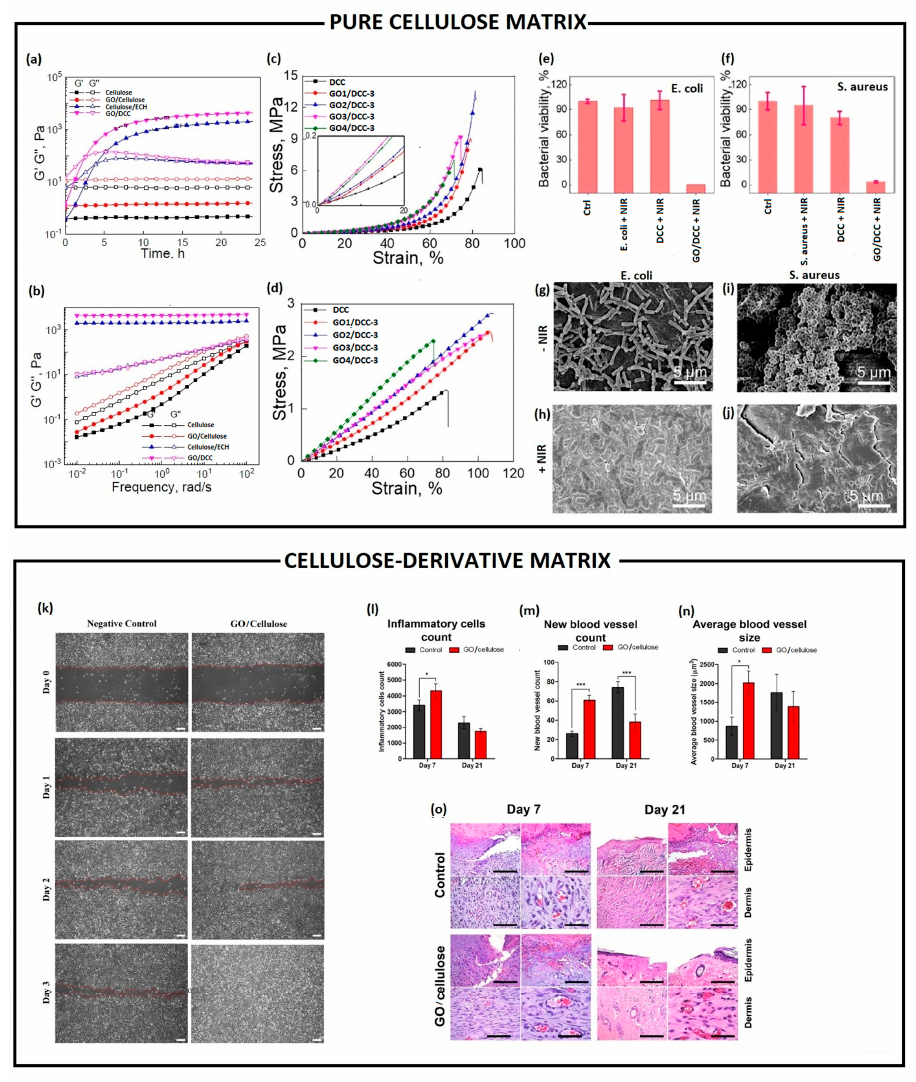
Figure 6. Pure cellulose matrix ( top ): rheological characterizations: ( a ) time- and ( b ) frequency-de- pendence of the storage modulus (G ′ ) and loss modulus (G ″ ) of a cellulose, cellulose/GO (2 wt%), cellulose/ECH (ECH:DCC molar ratio = 0.86), and cellulose/GO (2 wt%)/ECH (ECH:AGU molar ratio = 0.86). Mechanical characterizations: ( c ) compression strain–stress curves and ( d ) tensile strain– stress curves of cellulose/GO/ECH composite hydrogels with different GO contents. The insets show magnified plots of the responses in the low-strain range. Antimicrobial studies: relative percentage survival of ( e ) E. coli and ( f ) S. aureus after incubation with composite hydrogels with and without GO under NIR laser irradiation (power density of 2 W/cm 2 under 808 nm). SEM micrographs of E. coli ( g , h ) and S. aureu ( i , j ) on DCC4-3 before ( g , i ) and after ( h , j ) NIR irradiation. Adapted from [127]. Copyright (2022), with permission from Elsevier. Cellulose-derivatives matrix (bottom): ( k ) evaluation of GO-cellulose nanocomposite effect on in vitro wound healing through scratch assay performed by using a human endothelial cell line (EA.hy926) after 0, 1, 2 and 3 days post wound induction. Red-dotted lines indicate the wound edge (scale bar = 200 µ m); ( l ) inflammatory cells counts, ( m ) new blood vessels counts, and ( n ) average blood vessels size measured through ImageJ from a histological section of skin wound in rats treated with or without GO-cellulose nanocomposite for 7 and 21 days. Differences were evaluated using one-way ANOVA (* p < 0.05; *** p < 0.0001); (control) and treated with GO-cellulose for 7 and 21 days post-wound induction (scale bar = 50 µ m). Reprinted from [129]. Copyright (2022), with permission from